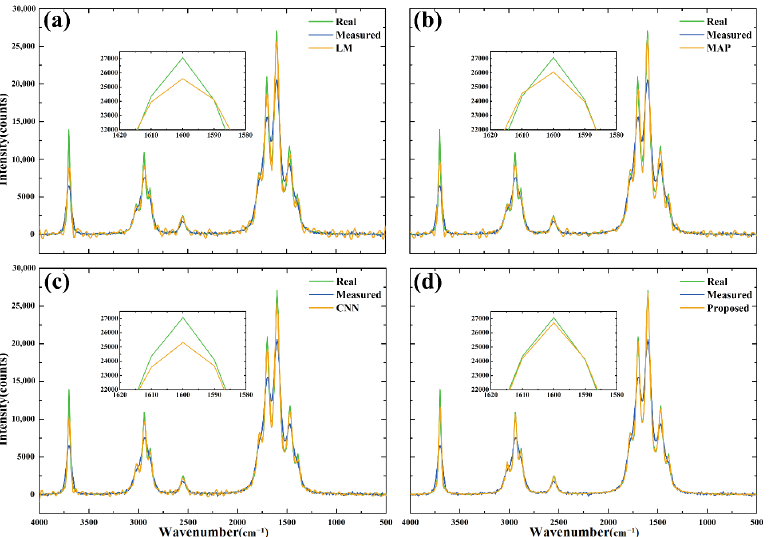
Figure 6. Estimated spectra obtained by the four methods. ( a ) the LM method; ( b ) the MAP method; ( c ) the CNN method; ( d ) the proposed method.